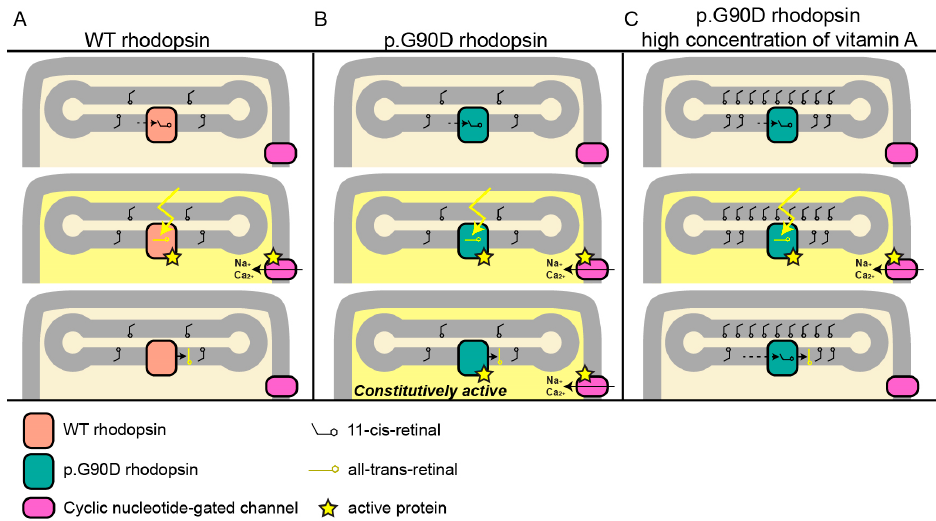
Figure 5. Proposed mechanism in which a higher concentration of vitamin A reduces the pathogenic effect of p.G90D. ( A ) Normal visual transduction. Light triggers the change in conformation from 11- cis -retinal to all- trans -retinal, which activates rhodopsin, which, in turn, via a series of events (not shown) causes the cyclic nucleotide-gated channel to open, allowing for the influx of Na + and Ca 2+ . ( B ) Constitutively active p.G90D rhodopsin. ( C ) Hypothesized reduction in the activity of p.G90D rhodopsin by increasing the concentration of vitamin A, and with that of 11- cis -retinal, which inactivates the opsin molecule. WT—wild-type.